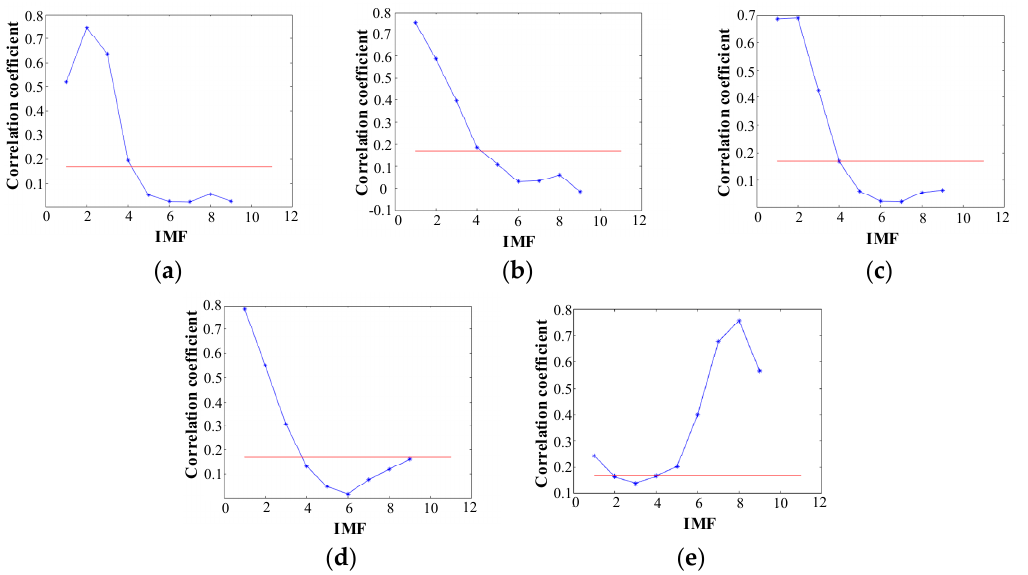
Figure 10. Correlation coefficient and threshold of each Intrinsic Mode Function (IMF) component in DN20. (a) 0.30 MPa; (b) 0.25 MPa; (c) 0.20 MPa; (d) 0.15 MPa; (e) Not leak.